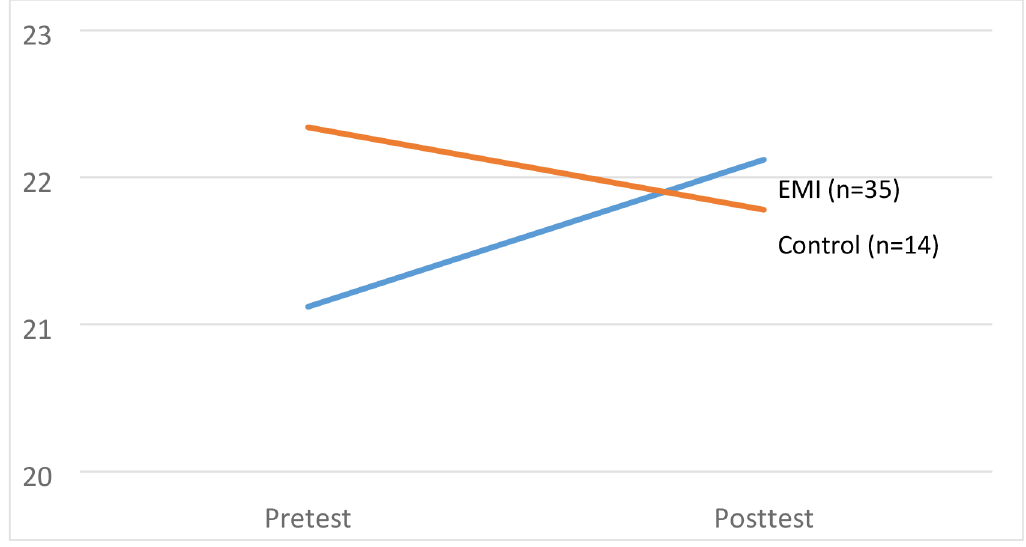
Fig 1. Estimated marginal means for hope scores by condition. Notes: Estimated marginal means are adjusted for pretest EWB and HWB.